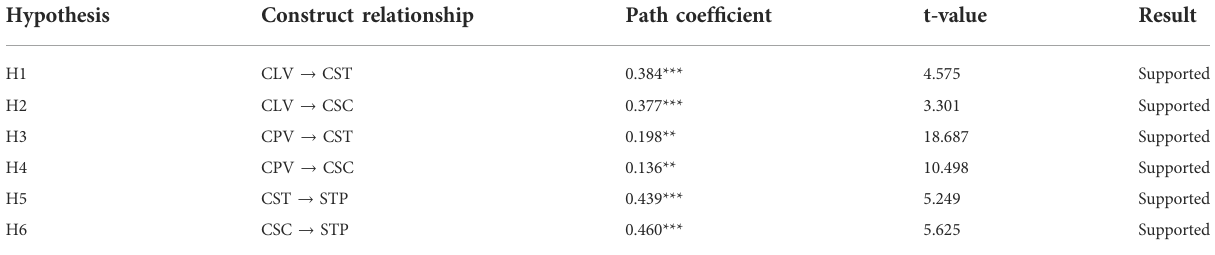
TABLE 6 Summary of hypothesis testing.